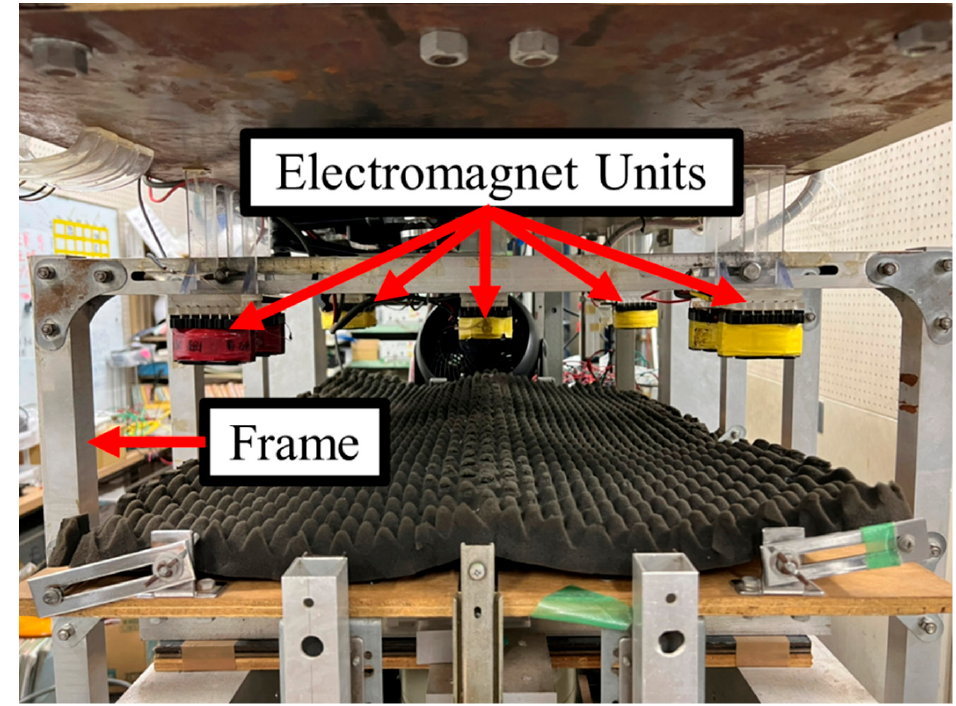
Figure 4. Photograph of the bending magnetic levitation system (side view).